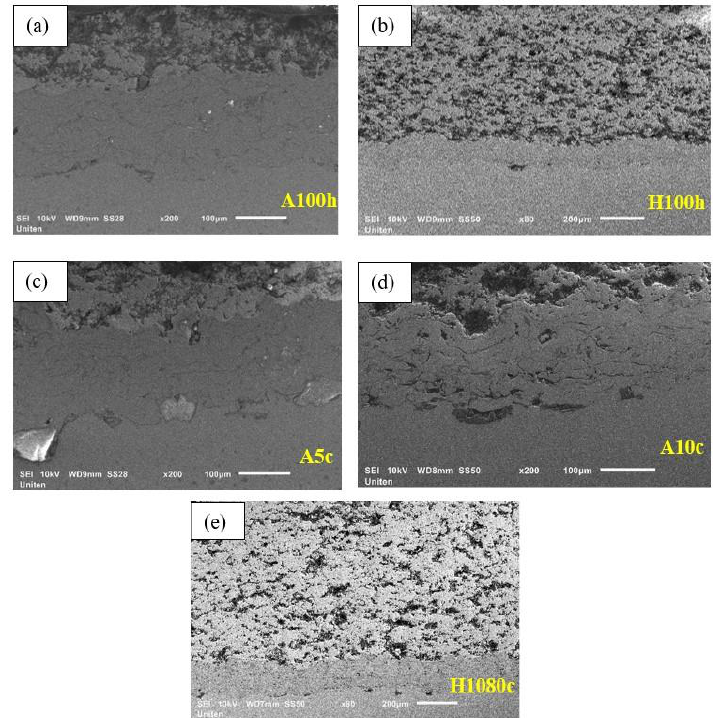
Figure 3. Wide view image of SEM micrograph, of isothermal ( a ) A100h, and ( b ) H100h and thermal cyclic test ( c ) A5c, ( d ) A10c, and ( e ) H1080c.